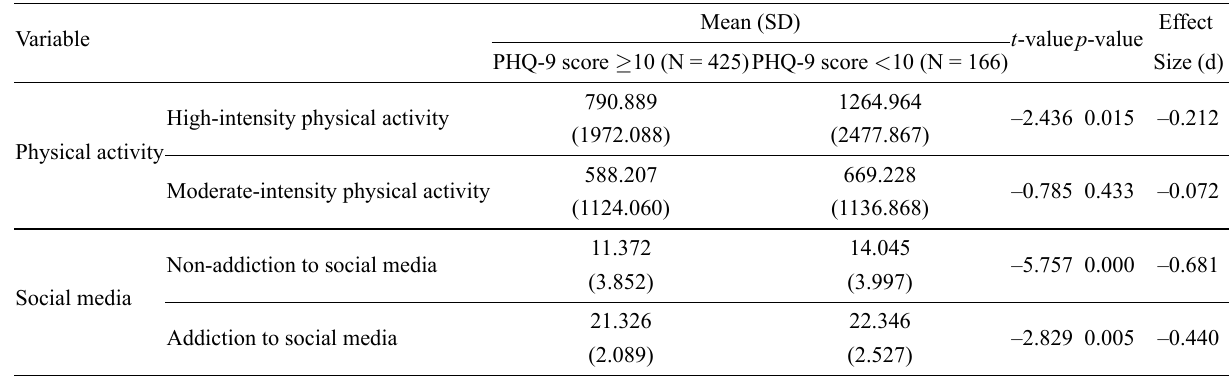
Table 2. An analysis of levels of physical activity and social media addiction according to the PHQ-9 level of depression (N =